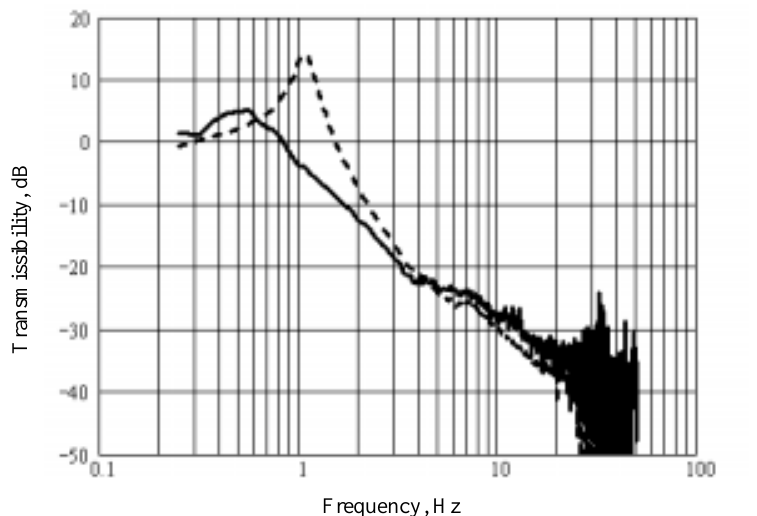
Fig. 11. Horizontal transmissibility of the actively isolated workstation with add-on active dampers. Dashed line – dampers off, solid line – dampers on.